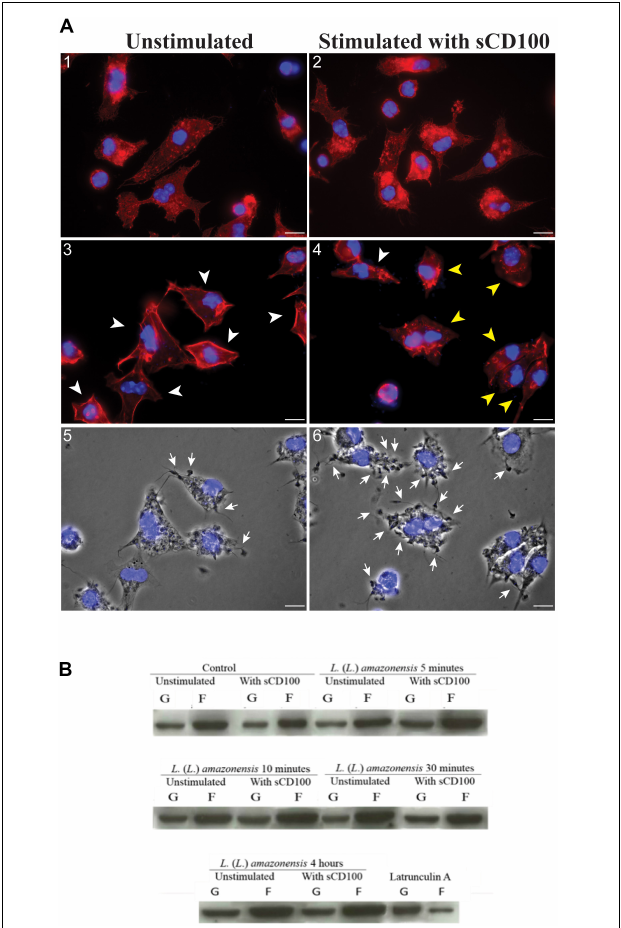
FIGURE 7 | Effect of sCD100 on actin polymerization in infected and non-infected macrophages. (A) Peritoneal macrophages from BALB/c mice unstimulated (1, 3, 5) or stimulated with 200 ng/mL of sCD100 (2, 4, 6) were infected with L. (L.) amazonensis at MOI of 10 for 30 min (1, 2) or 4 h (3, 4), followed by staining with phalloidin Red: Actin (labeled with phalloidin-Texas Red), Blue: nuclear DNA and kinetoplast (DAPI). Images were captured in DMI6000B/AF6000 (Leica) fluorescence microscope coupled to a digital camera system (DFC 365 FX). White bars correspond to 10 µ m. The arrowheads point to macrophages presenting cortical (white) or cytoplasmic (yellow) organization of F-actin. Contrast phase of the samples at 4 h from unstimulated and stimulated with sCD100 (5, 6). The arrows point to parasites attached to macrophages. The images are representative of two independent experiments. (B) Western blot for actin in soluble and insoluble fractions of bone marrow macrophages incubated with or without sCD100, infected or not for 5, 10, 30 min or 4 h. This representative image shows soluble actin (supernatant, G-actin), and polymerized actin (pellet, F-actin) bands, and the graph shows F/G actin ratio after densitometry. Results of a representative experiment of three with the same profile.